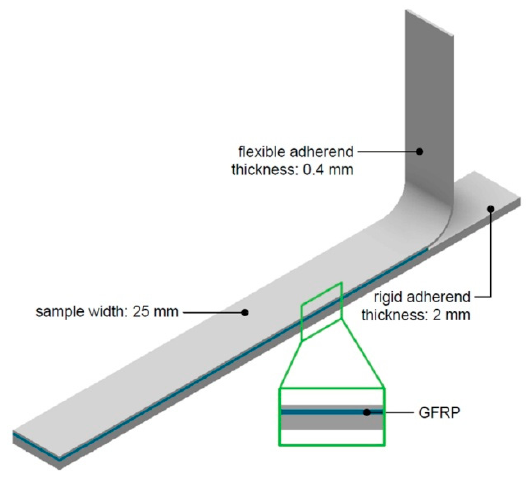
Figure 7. Sample for testing the interlaminar strength of the FML composite in the drum peel test.